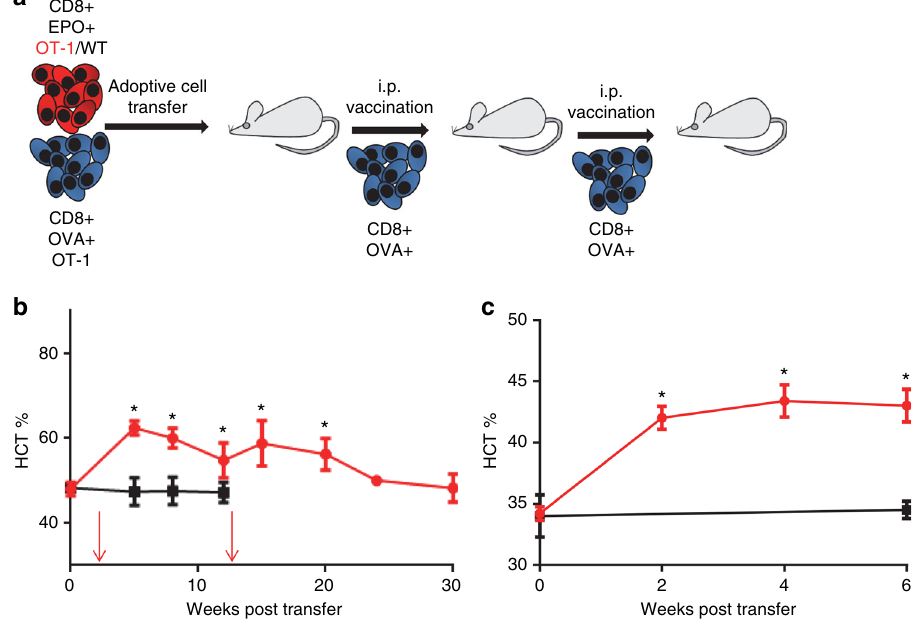
Fig. 6 EF1 α -mEPO transposon-modi fi ed T lymphocytes raise hematocrit in vivo. a Schematic representation of experiment evaluating ability of adoptively transferred transposon-modi fi ed T cells to raise hematocrit in WT C57Bl6 mice. Red cells indicate OT-1 (red) or wild-type CD8 + T cells transfected with pT-ef1 α -mEPO and pCMV-m7pB. b Plot of mean hematocrit measurements observed in mice that received 2 × 10 7 pT-EF1 α -mEPO genome-modi fi ed wild- type T cells (black) or OT-1 T cells (red), and an i.v. OT-1 T-cell vaccine. Additional i.p. T-cell vaccines were administered (red arrow) on days 7 and 14, and then again on days 84 and 91 (OT-1 group) after initial transfer. Statistical analysis of hematocrit measurements were performed by comparing to